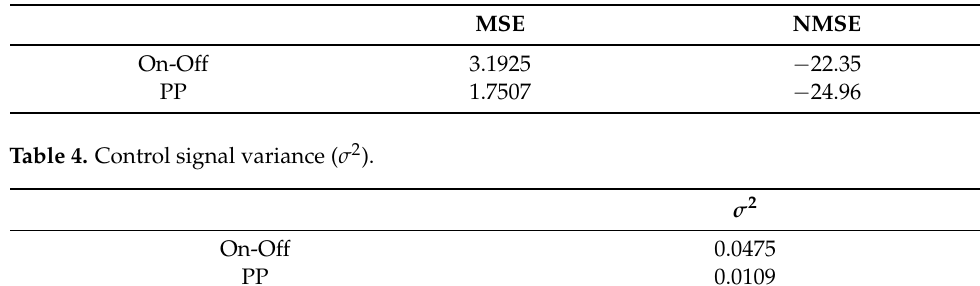
Table 3. MSE and Normalized MSE (NMSE).